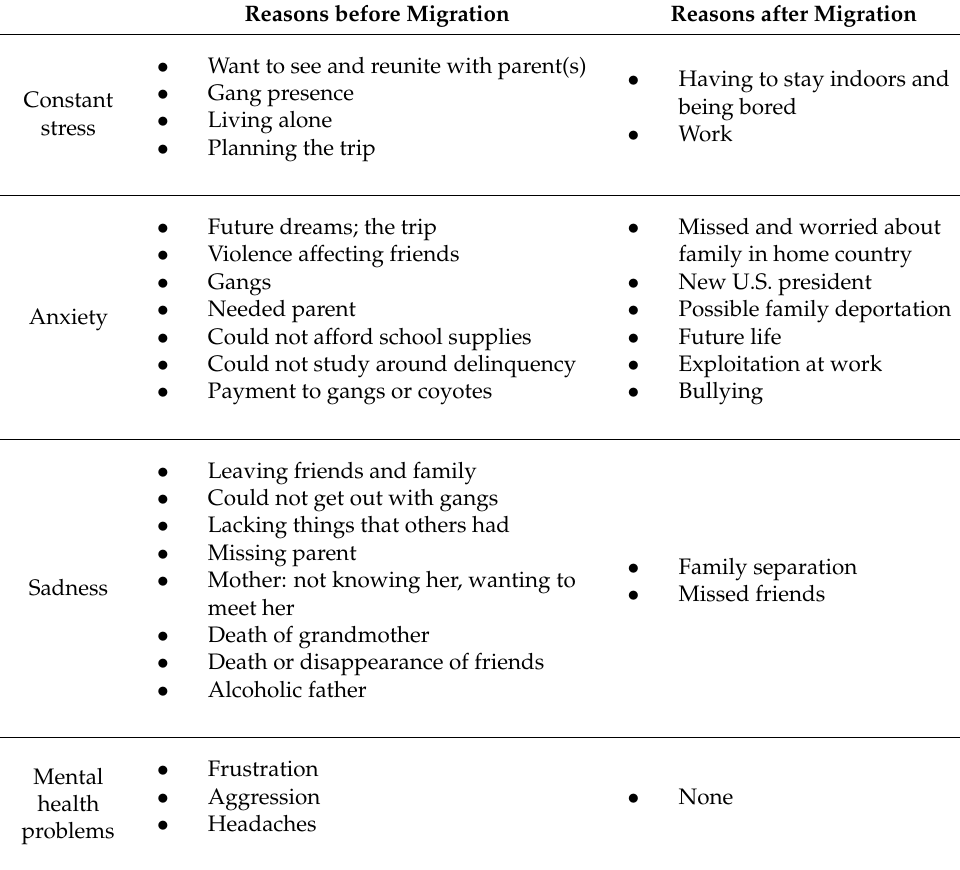
Table 4. Mental Health Worries and Stressors Pre- and Post-Migration.